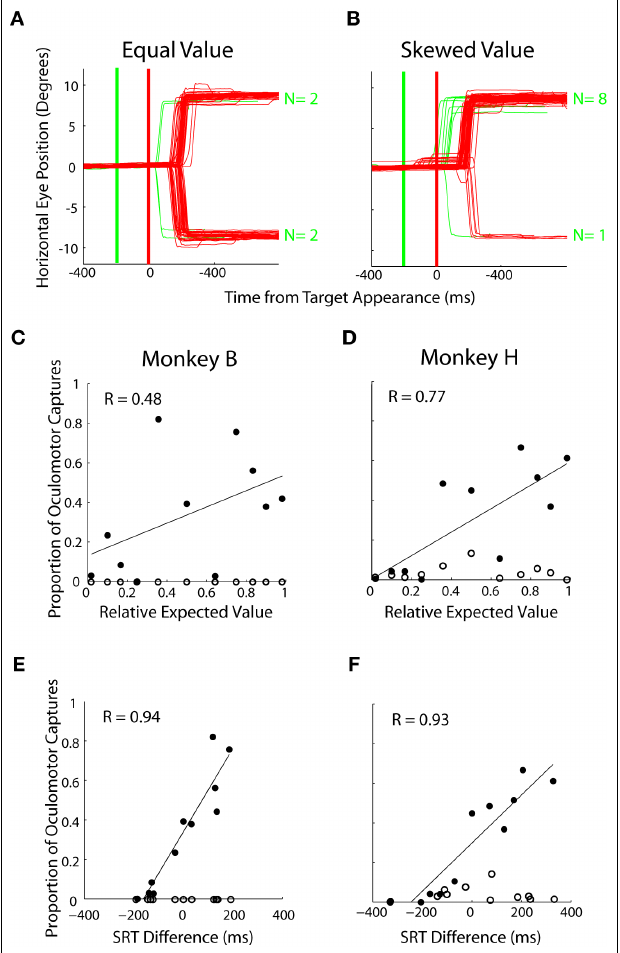
FIGURE 7 | Influence of expected value on oculomotor captures. (A,B) Individual eye traces for equal value (50% left probability/50% left reward magnitude) and skewed value (50% left probability/62% left reward magnitude) blocks of trials. Red lines indicate target-directed saccades, green indicate distractor-directed saccades.Thick lines indicate time of distractor (green) and target (red) appearance, respectively. (C,D) Each point is calculated from approximately 700 trials with data collapsed for left and right oculomotor captures for the same prospects. Filled circles represent oculomotor captures to distractors that appeared at potential target locations. Unfilled circles represent oculomotor captures to vertical distractors where no target was ever presented. (E,F) Relationship between relative SRT and proportion of oculomotor captures on each block. Same data as in (C,D)